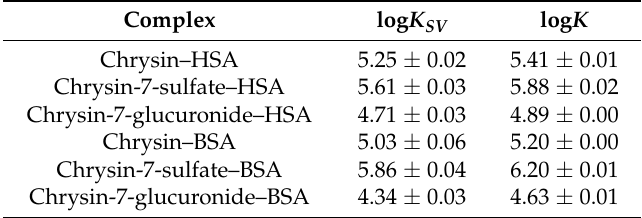
Stability of flavonoid–albumin complexes. Decimal logarithmic values ( ± SEM) of Stern–Volmer quenching constants ( Ksv , unit: L/mol) and binding constants ( K , unit: